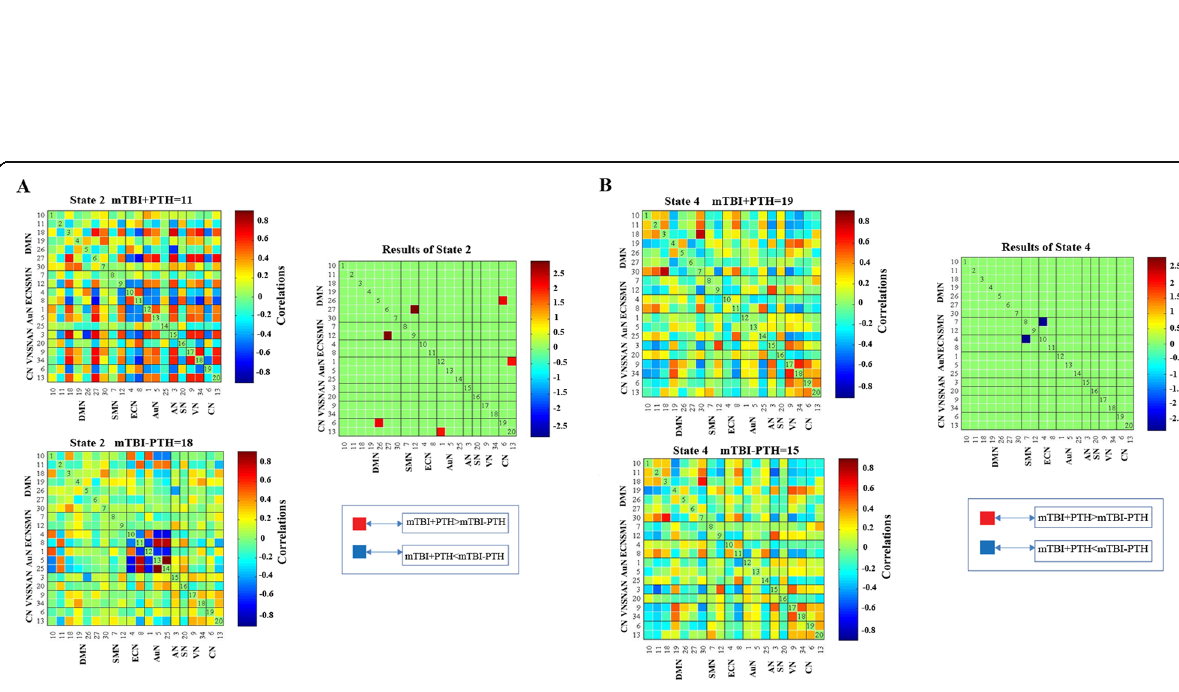
Fig. 4 Differences in dynamic functional network connectivity(dFNC) between groups with (PTH) and without (PTH). DFNC assumes that whole brain connectivity sequentially iterates through a finite set of connectivity patterns known as dFNC states. Here only State 2 and state 4 are shown because significant differences between groups (PTH+ and PTH-) in dFNC were observed only in these states. The top and bottom row on the left side represents median connectivity matrices, called centroids (i.e. basis correlation patterns), in PTH+ and PTH- respectively. Figures also display the number of subjects that displayed correlation for at least ten windows and were included in the statistics to determine group